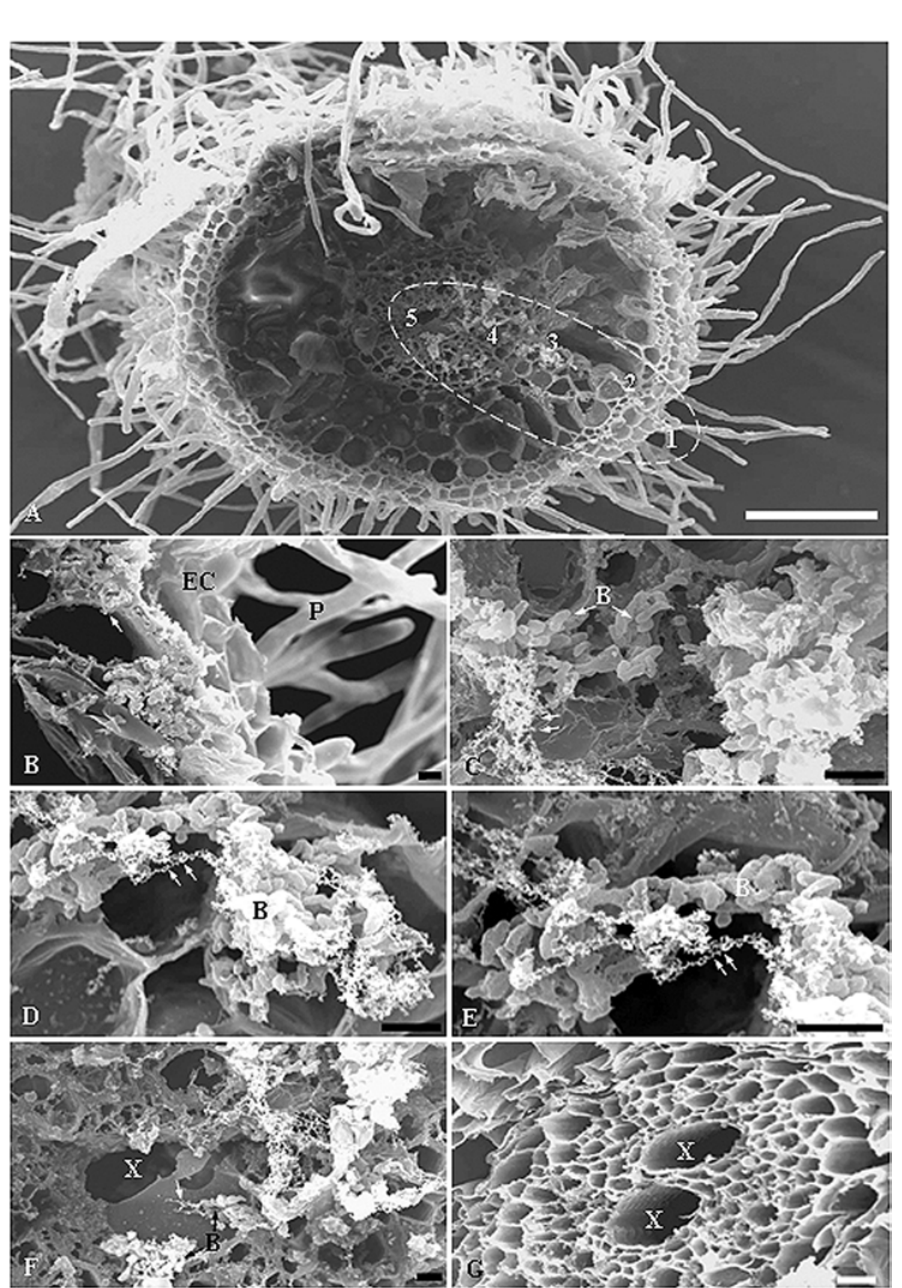
Fig. 2 – SEM showing the infection route by B. kururiensis . ( A ) General view of a transversal section of an infected root where five zones ( 1-5 ) are distinguished characterizing the pathway taken by bacteria from the epidermal surface towards the xylem vessels. ( B ) Detailed view of zone 1 : bacteria invade the inner tissues through the hair base, crossing epidermal cells and the apoplast, eventually migrating to the cortex cells. ( C, D ) View of zones 2 and 3 , respectively, evidencing clusters of bacteria arranged in strings within the inner cortex, along the vascular cylinder. Filamentous material (white arrows) is observed on root cells, nearby adhered bacterial clusters. ( E ) Vascular cylinder (zone 4 ) showing bacteria still arranged in strings. Note that during the root invasion process, bacteria are apparently translocated through intercellular spaces. ( F ) Center of a vascular cylinder (zone 5) evidencing the arrival of bacterial strings inside the xylem (X) vessels, best visualized in ( G ). Transversal section of an uninfected control root, showing xylem vessels free from bacteria. EC , epidermal cells; P , root hair; X , xylem vessels, B , bacteria. Bar = 1 μ